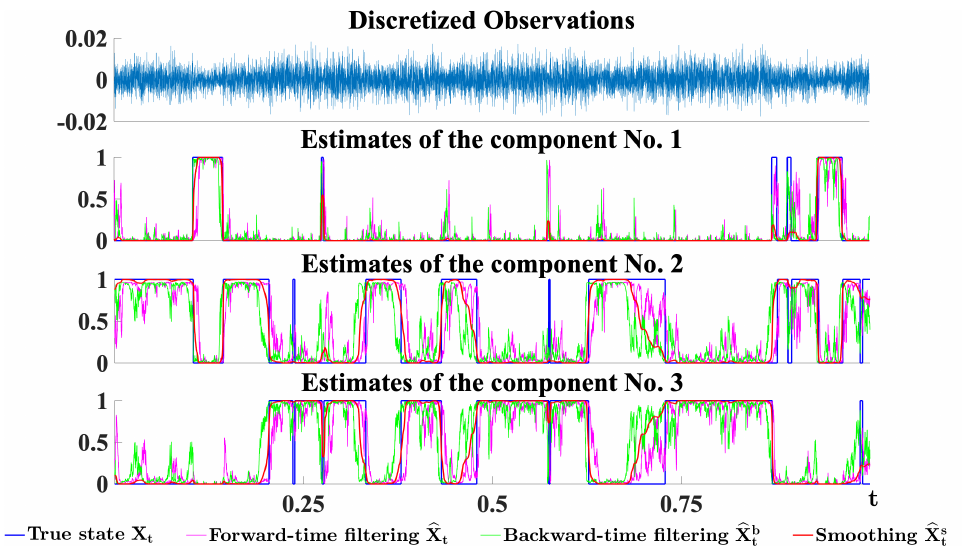
Figure 2. Available discretized observations, true MJP state and its filtering and smoothing estimates.